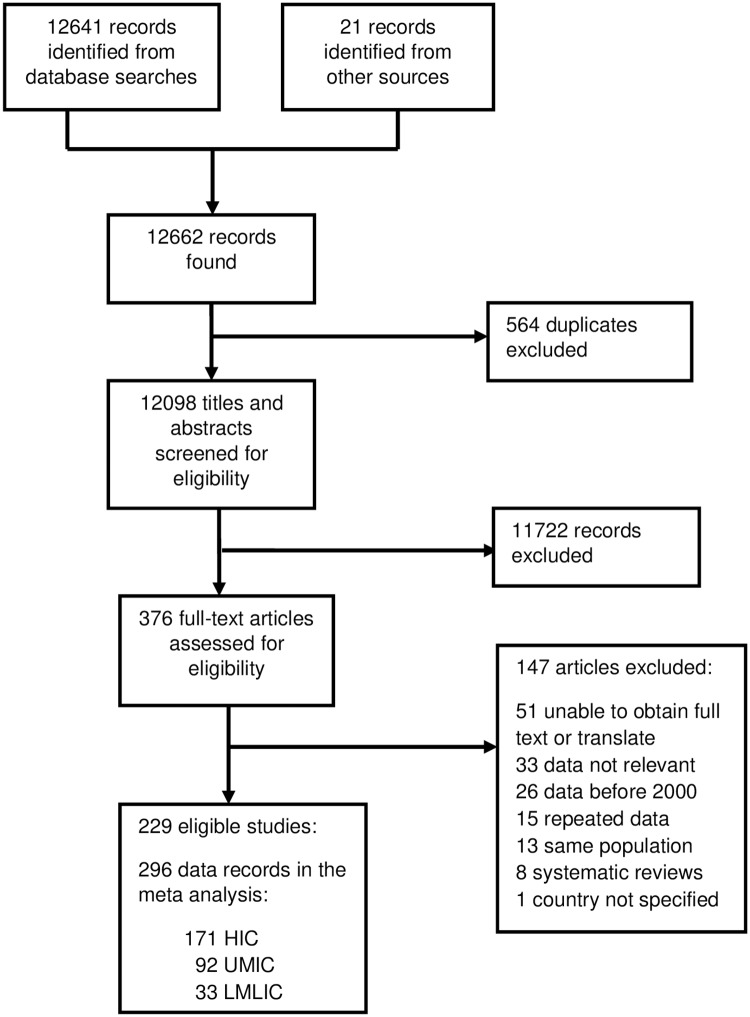
Study selection.